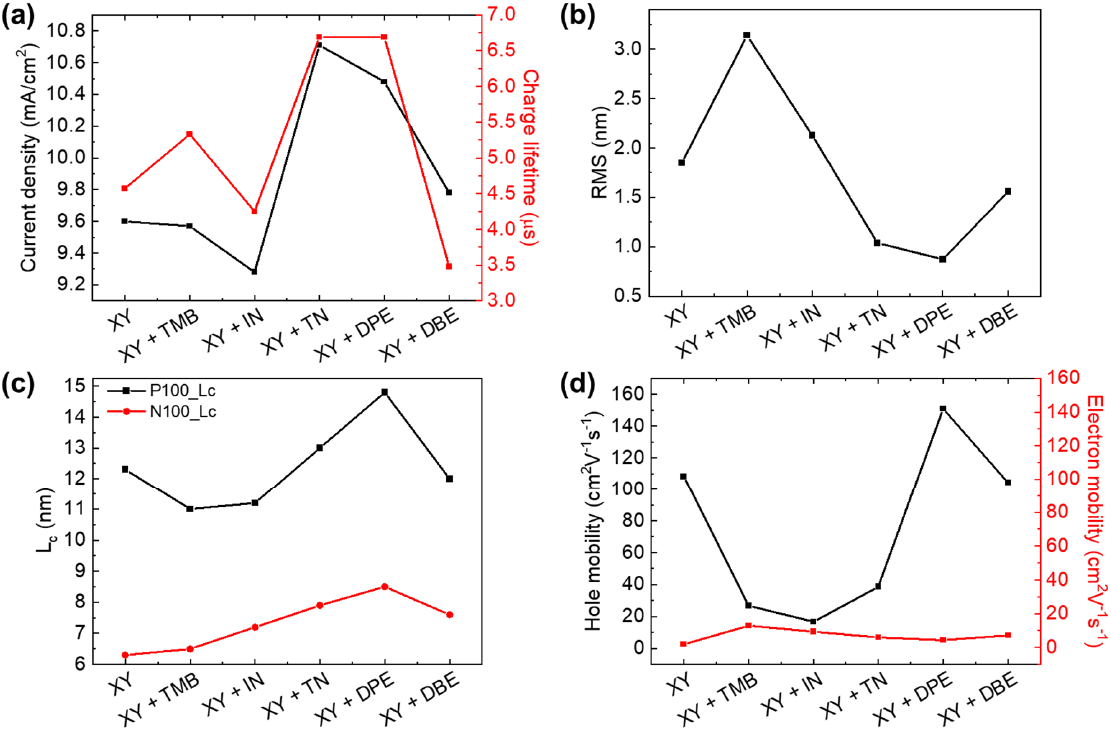
Figure 12. Correlations between ( a ) J sc and charge lifetime, ( b ) RMS, ( c ) L c in the (100) plane of each polymer, and ( d ) hole and electron mobilities.